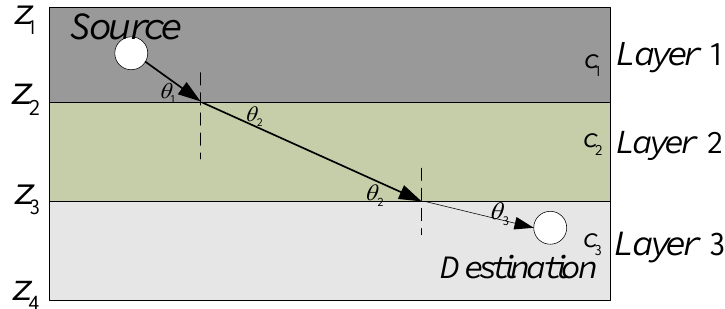
Figure 1. Sound ray propagation in stratified ocean medium.